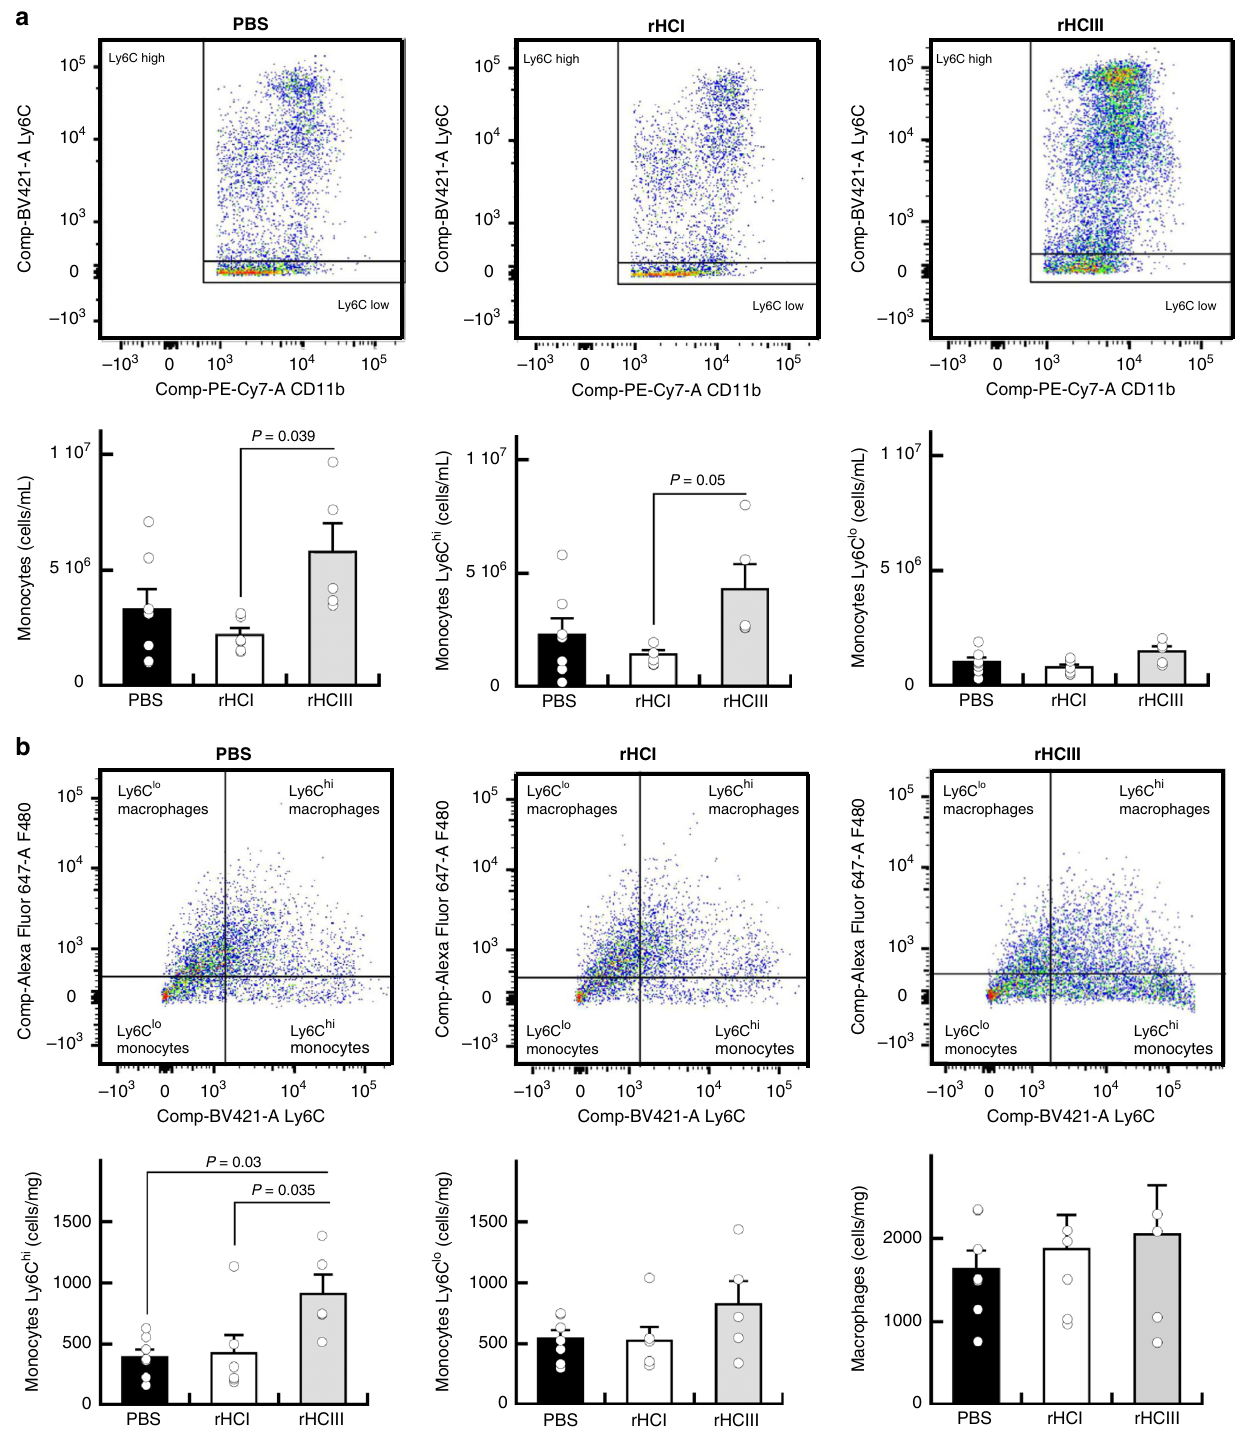
Fig. 6 rHCIII matrix increases Ly6C hi monocyte mobilization and accumulation in the heart. Flow-cytometry plots show F480 and Ly6C expression of mononuclear cells (CD45 + CD11b + Ly6G - ) in the blood ( a ) and heart ( b ) of mice at 2 days post treatment. Macrophages were considered F480 + , while monocytes were F480 − and classi fi ed based on the expression of the Ly6C marker. The data are presented as the mean ± SEM ( n = 5 – 7). P- values were determined by a one-way ANOVA for effect of treatment followed by Holm ’ s correction for multiple comparisons. Source data are provided as a Source Data fi le. For a , b , n indicates the number of mice per group 2 days post treatment in wild-type mice showed an increase in the wound healing in the long-term. This may be an explanation for mobilization of monocytes into the blood and greater accumu- the increased expression of cardiac troponin I in the border zone lation of Ly6C hi cells in the myocardium for the rHCIII group. and Cx43 in the remote region of rHCI-treated hearts compared with either PBS or rHCIII. The analysis of monocyte populations Also, an increased number of Ly6C lo cells was seen in the spleen NATURE COMMUNICATIONS| (2019) 10:4866